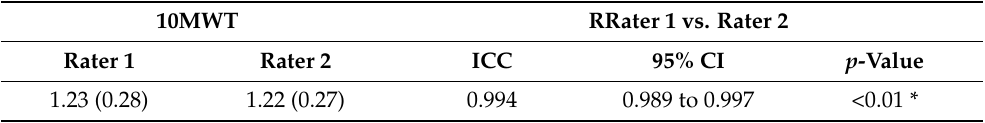
Table 2. Inter-rater reliability of the 10MWT.